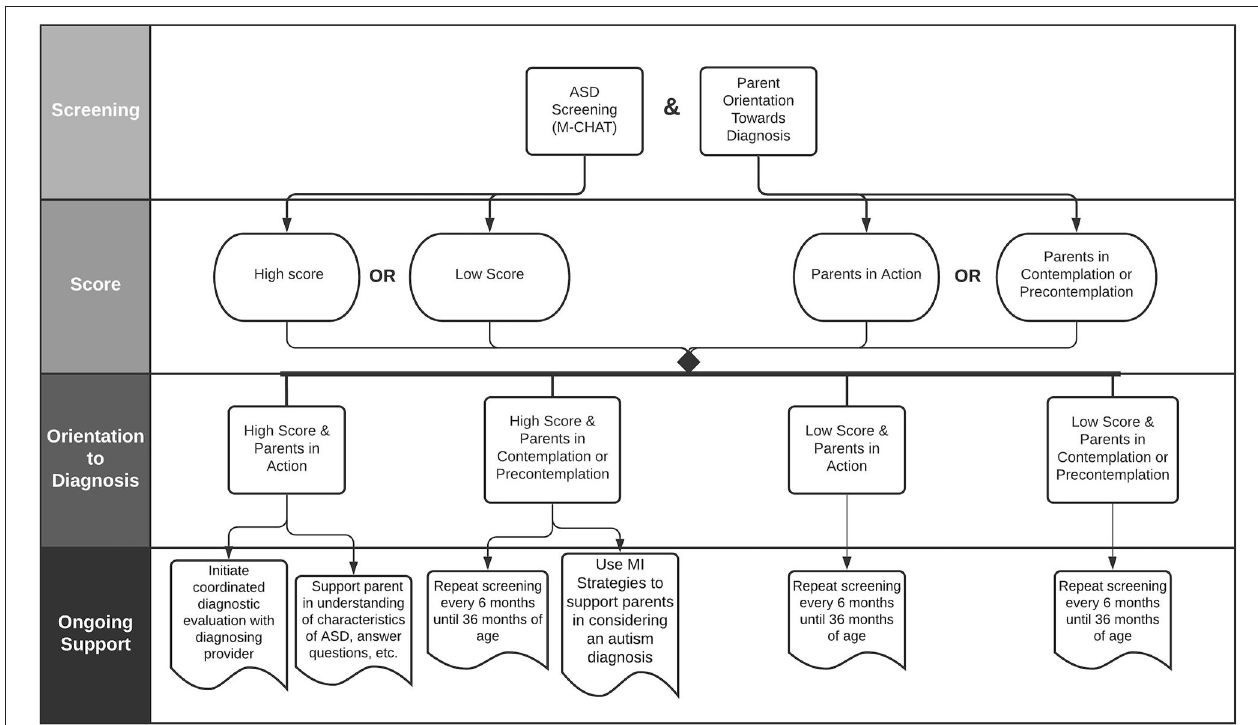
FIGURE 1 | Parent orientation toward diagnosis